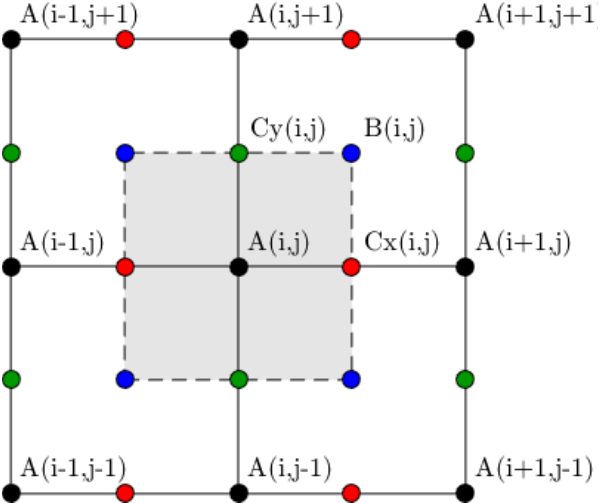
Figure A1. The four Arakawa grids: regular (A; black), staggered in the x direction (Cx; red), staggered in the y direction (Cy; green), and staggered in both directions (B;